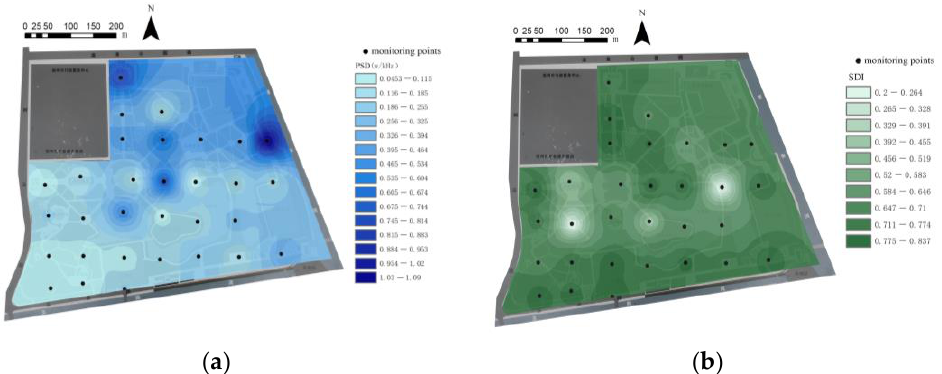
Figure 10. ( a ) Spatial distribution characteristics of the PSD; ( b ) spatial distribution characteristics of the